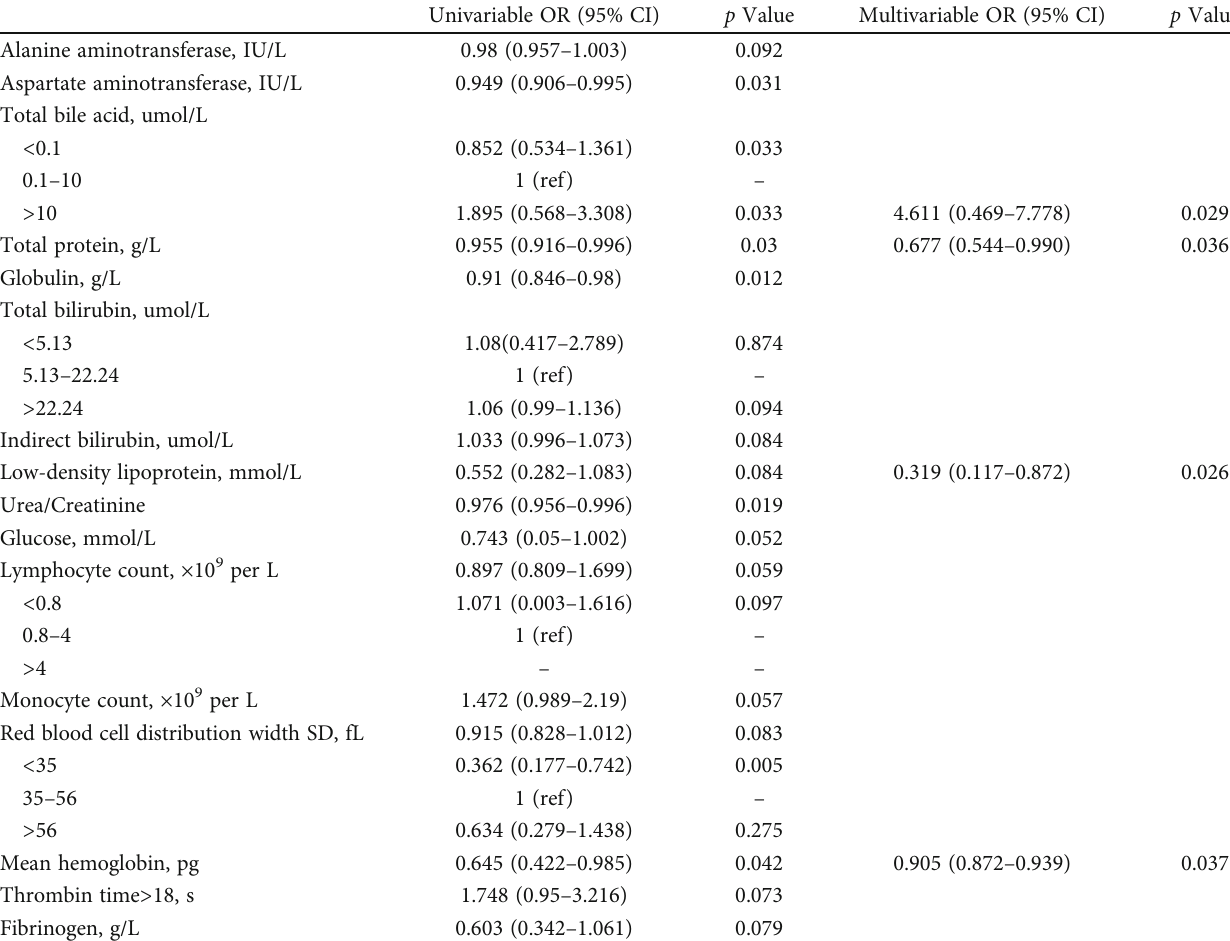
Table 7: Risk factors associated with female COVID-19 patients with